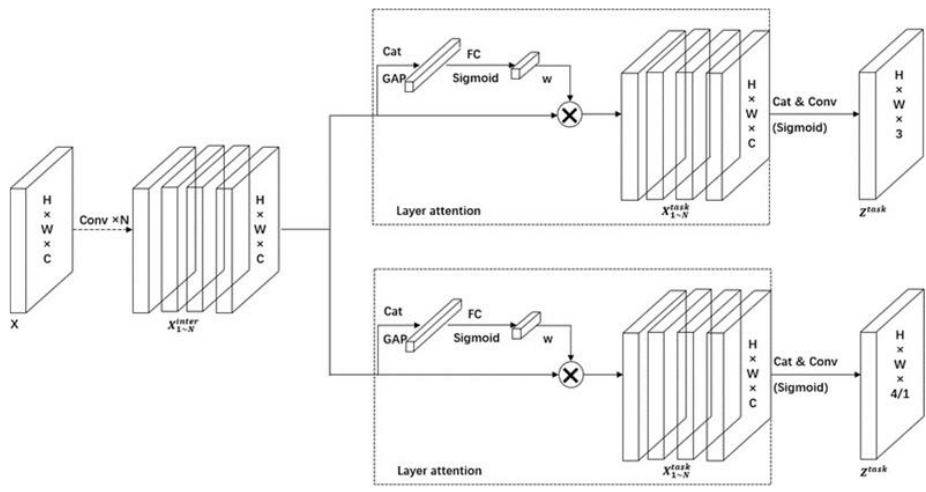
Figure 5. The improvement head for